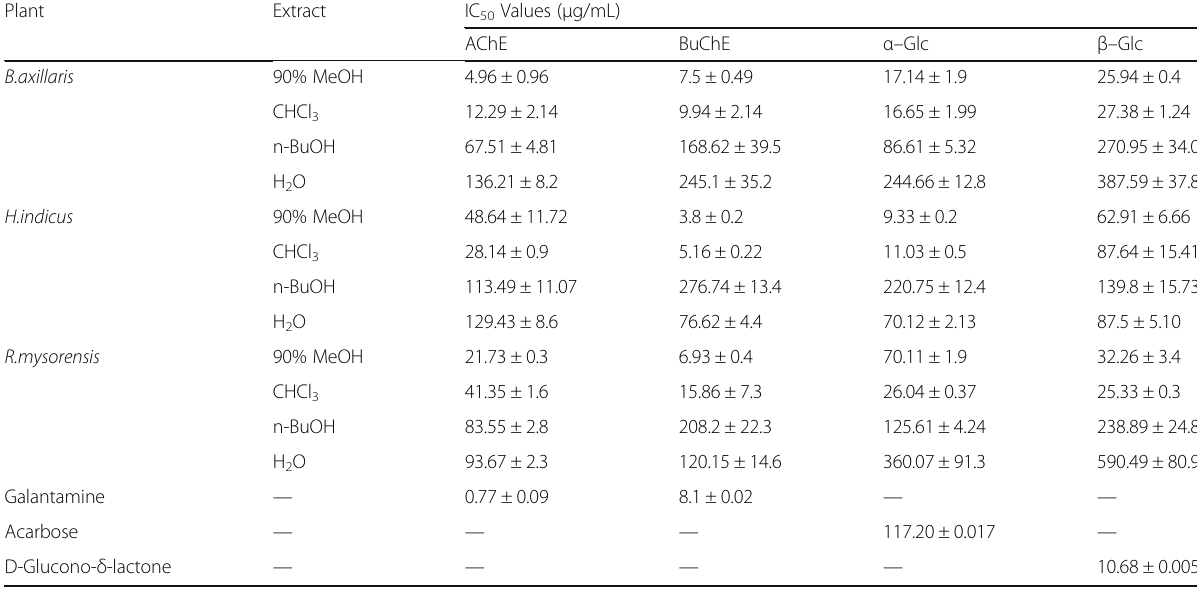
Table 2 IC 50 Values of 90% methanolic extracts and its derived fractions for AChE, BuChE, α – and β – Glucosidase inhibition assays